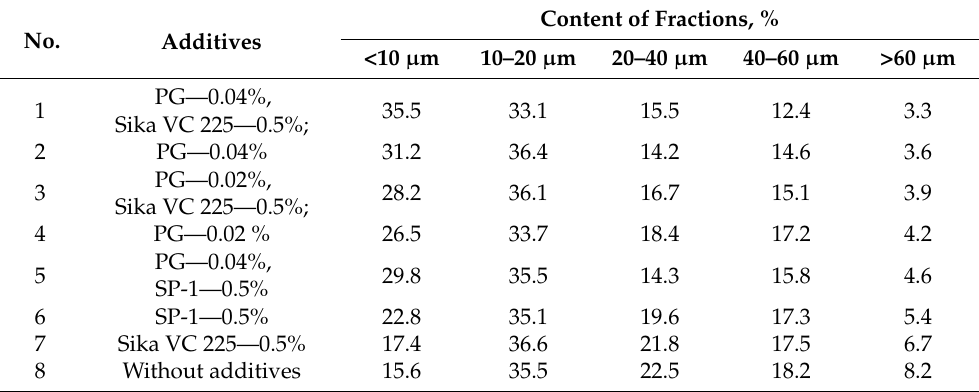
Table 2. Composite cements grain composition.